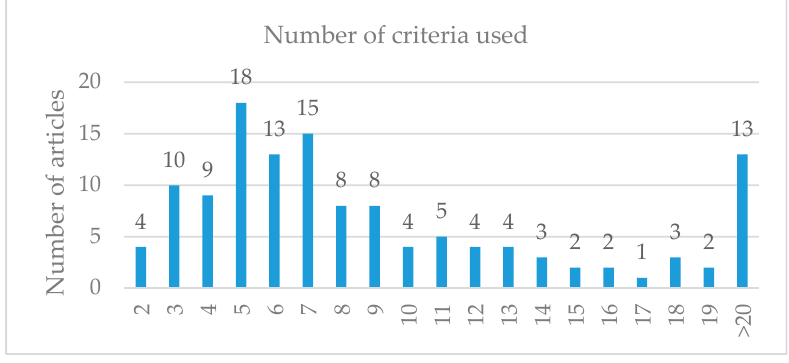
Figure 3. Number of criteria used.